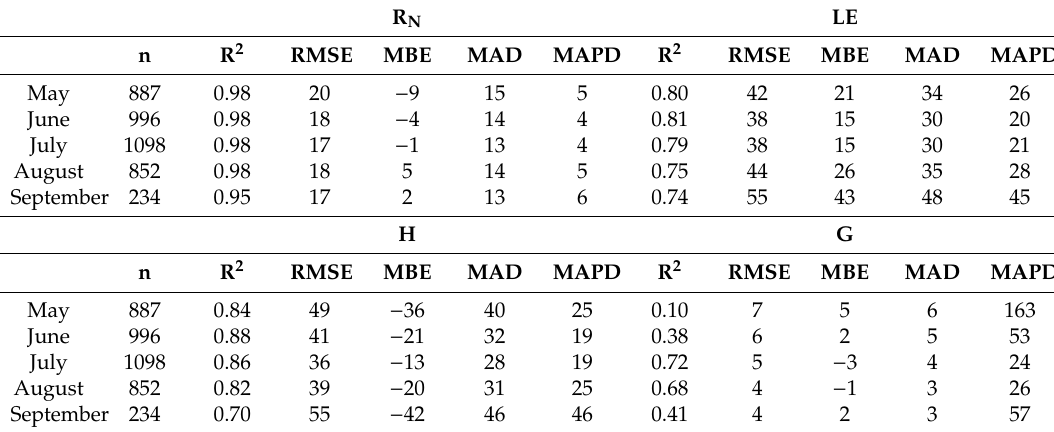
Table 3. Monthly results of the model agreement and error estimation compared to observed flux tower data at the black spruce setting using an initial TSEB α PTC value of 0.6. n is the number of 30-min